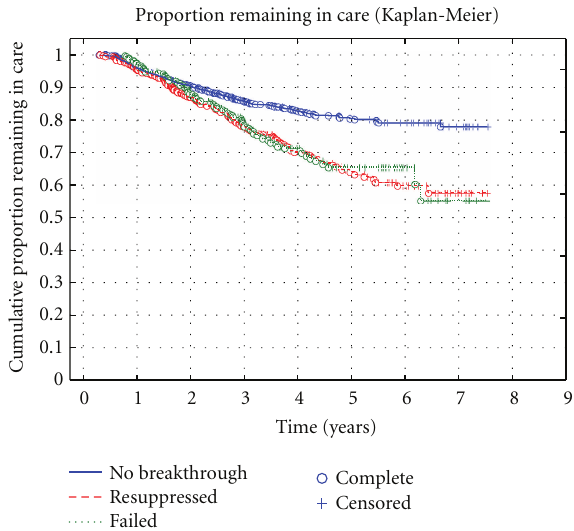
Figure 3: A Kaplan-Meier survival curve depicting risk of loss to care overtime. Losses include deaths and those lost to